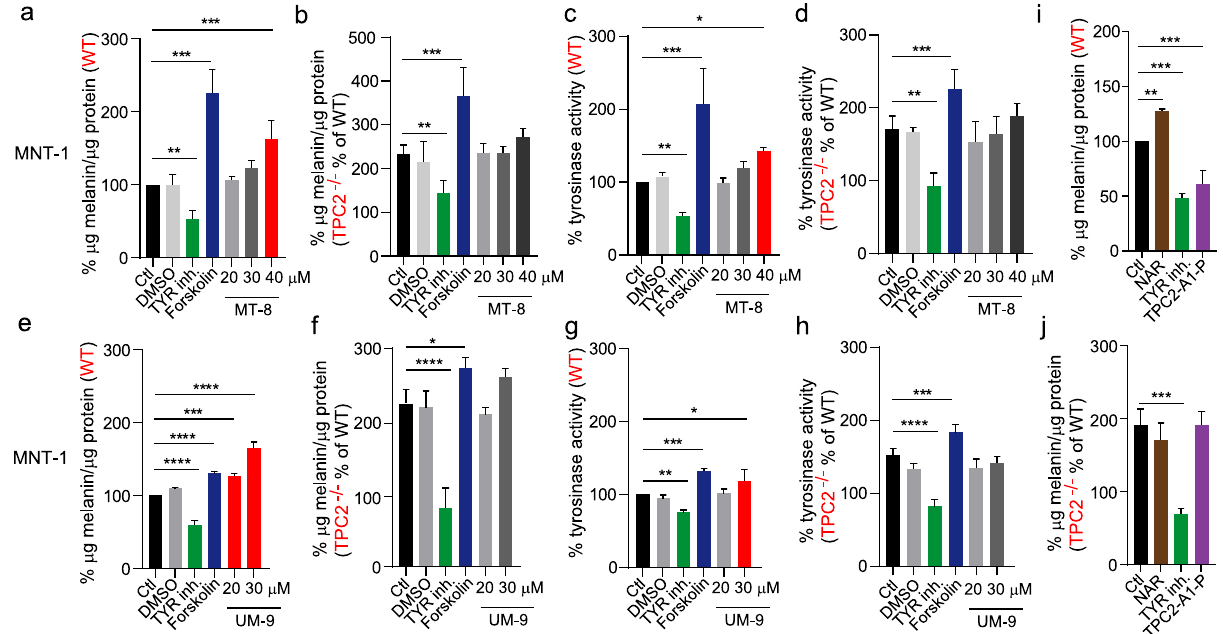
Figure 4. Melanin production and tyrosinase activity in flavonoid treated WT and TPC2 −/− MNT-1 cells. ( a ) and ( b ) Melanin content in WT and TPC2 −/− MNT1 cells after treatment with different concentrations of MT-8 (20, 30 and 40 µM) or DMSO, and with tyrosinase inhibitor (10 µM) and forskolin (10 µM) as negative and positive controls, respectively. ( c ) and ( d ) Tyrosinase activity in WT versus TPC2 −/− MNT1 cells after treatment with MT-8 in different concentrations. ( e ) and ( f ) Melanin content in WT and TPC2 −/− MNT1 cells after treatment with different concentrations of UM-9 (20 and 30 µM) or DMSO, and with tyrosinase inhibitor (10 µM) or forskolin (10 µM) as negative and positive controls. ( g ) and ( h ) Tyrosinase activity in WT versus TPC2 −/− MNT1 cells after treatment with UM-9 in different concentrations. ( i ) and ( j ) Melanin content in WT and TPC2 −/− MNT-1 cells after treatment with naringenin (NAR; 50 µM), tyrosinase inhibitor (10 µM), or TPC2-A1-P (TPC2 activator; 50 µM). Statistical significance was determined by one-way ANOVA followed by Dunnett ‘s multiple comparisons test. Shown are mean values ± SEM, (n = 3, each). *P < 0.05, **P < 0.01, ***P < 0.001, ****P < and DMSO control on migration of WT and TPC2 −/− MNT-1 cells. We confirmed the highly significant assay windows between WT and TPC2 −/− MNT-1 cells for migration at different time points (Fig. 5j–k). Application of MT-8, UM-9, and NAR reduced the migration efficiency of MNT-1 WT cells to TPC2 −/− values (Fig. 5l–m) while addition of the compounds to TPC2 −/− MNT-1 cells did not significantly reduce migration efficiency any further (Fig. 5l–m), again corroborating on-target effects of the compounds. Likewise, we assessed the effect of the compounds and DMSO control on invasion of WT and TPC2 −/− MNT-1 cells (Fig. 5n–p). Application of MT-8, UM-9, and NAR reduced the invasion efficiency of MNT-1 WT cells to TPC2 −/− values while addition of the compounds to TPC2 −/− MNT-1 cells did not significantly reduce invasion efficiency any further (Fig. 5n–p). MITF protein levels are reduced in TPC2 knockout melanoma cells while GSKβ levels are increased. MITF is a major regulator of melanoma proliferation and progression, and mutations in MITF are associated with Tietz albinism-deafness syndrome, Waardenburg syndrome type 2A, and melanoma development 18,19 . Several pathways are involved in the regulation of MITF such as the RAS/RAF/MEK/ERK pathway, the PI3K/AKT, and the Wnt/GSK3β/β-Catenin signalling pathways 20 . Melanin formation is also trig- gered by melanocyte-stimulating hormone (MSH), a peptide hormone encoded by the proopiomelancortin gene (POMC). MSH binding to MC1R results in the induction of MITF via CREB (cAMP response element-binding protein) 20 . We performed Western blot experiments to assess protein levels of MITF and several key proteins involved in the regulation of MITF expression. We found that in TPC2 −/− MNT-1 cells MITF protein levels were strongly decreased compared to WT cells. We confirmed this result by using three different antibodies against MITF (Fig. 6a,b and Fig. S4). We next assessed the expression levels of CREB, ERK, Akt, and GSK3β (Fig. 6c–j, Fig. S4, and Fig. 7). While ERK, Akt, and CREB showed no significant differences, the expression of GSK3β was significantly increased. GSK3β is a negative regulator of MITF expression and can target MITF for proteasomal degradation. Activation of Wnt signalling can prevent this process by increasing the endolysosomal destruction of GSK3β 21 . An increased level of GSK3β suggests reduced degradation of the GSK3β containing destruction complexes in endolysosomes, resulting in increased GSK3β-dependent MITF degradation. To further corroborate this hypothesis we assessed the MITF protein stability in WT and TPC2 −/− MNT-1 cells by using cycloheximide (CHX). CHX is an inhibitor of protein synthesis and can be used to determine the longevity of proteins 22 . In Western blot experiments we found an increased sensitivity of TPC2 −/− compared